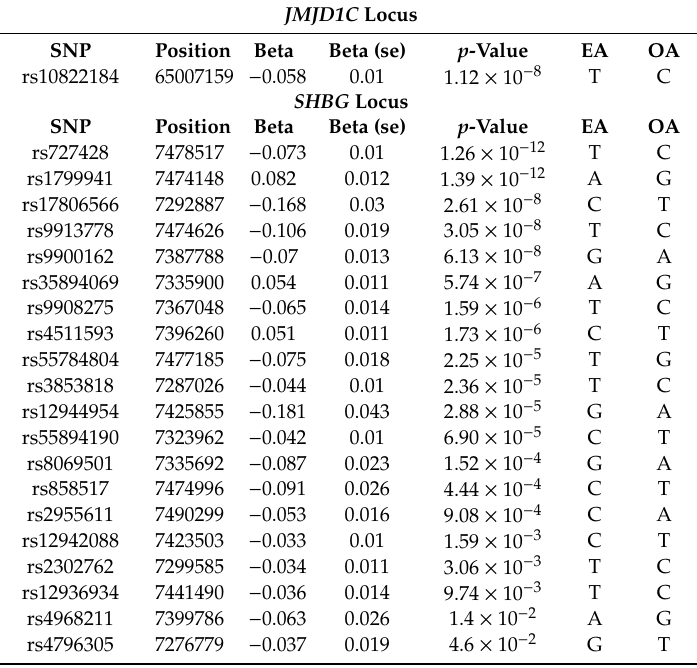
Table 1. Detailed composition of the genetic variants used in the Mendelian randomization